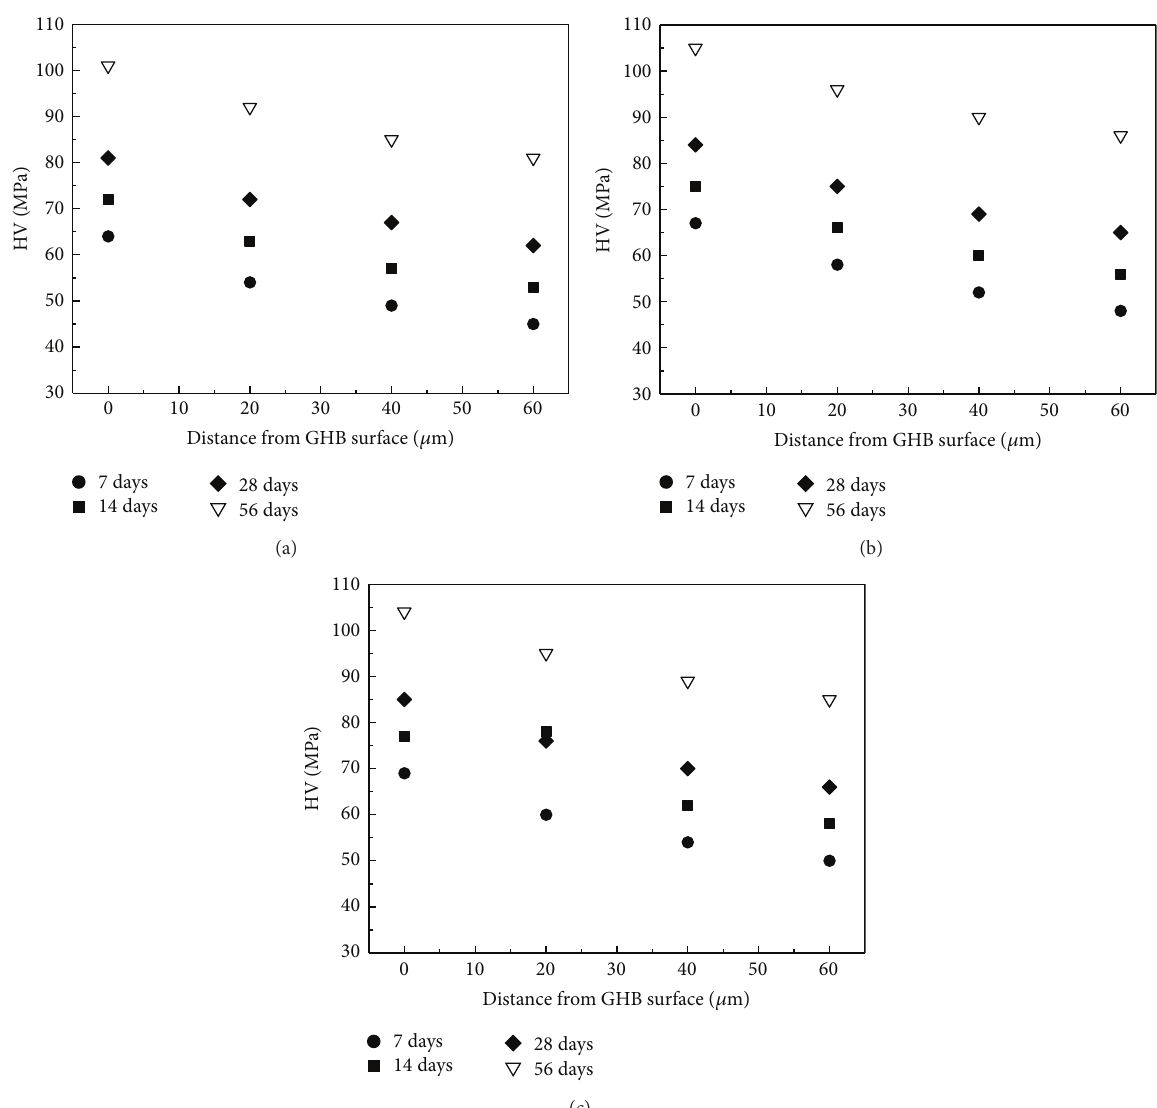
Figure 15: The influence of relative humidity on the interfacial HV of cement paste ((a) for 30%, (b) for 60%, and (c) for 90%).